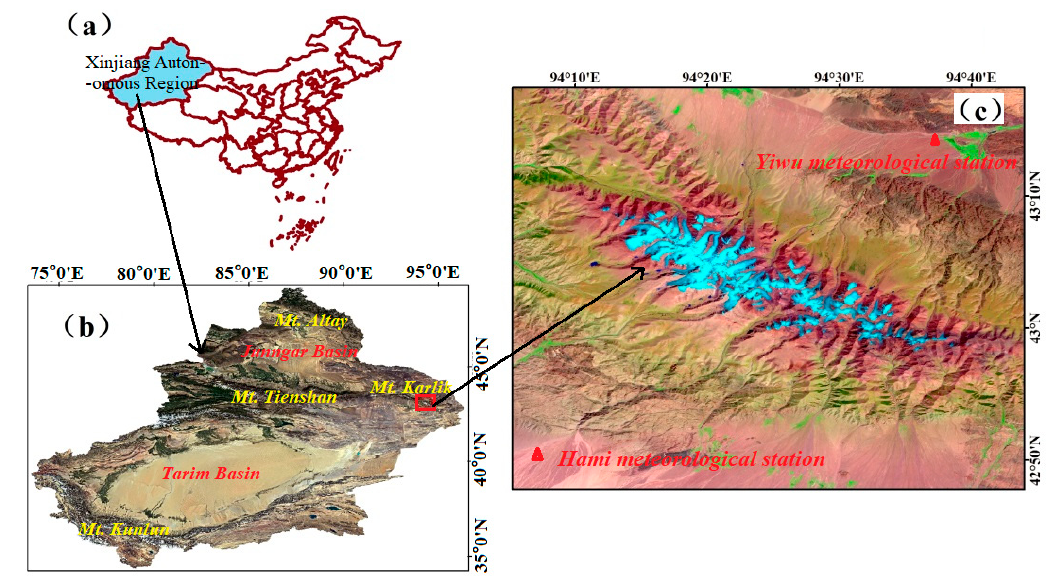
Figure 1. The geographical location of the study area. ( a ) Map of China showing Xinjiang Autonomous Region (XAR). ( b ) Location of Karlik Mountain (red rectangle) within the XAR. ( c ) Landsat 5 image of Karlik Mountain, with glaciers represented by the blue area.